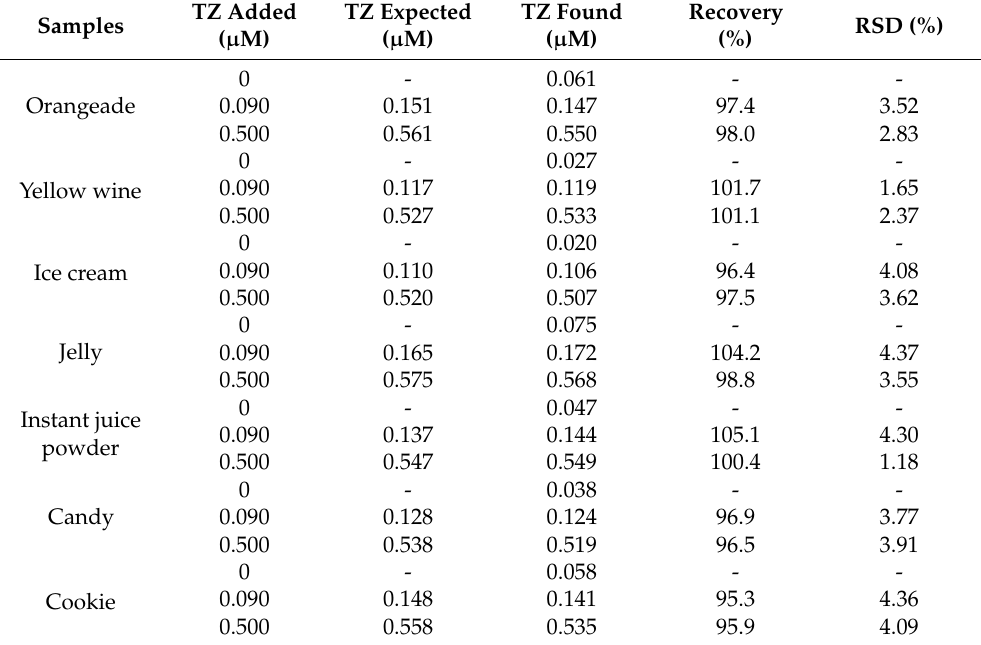
Table 1. Detection results for TZ in samples using GCE/GO–PtCo@MIPDA ( n = 6).